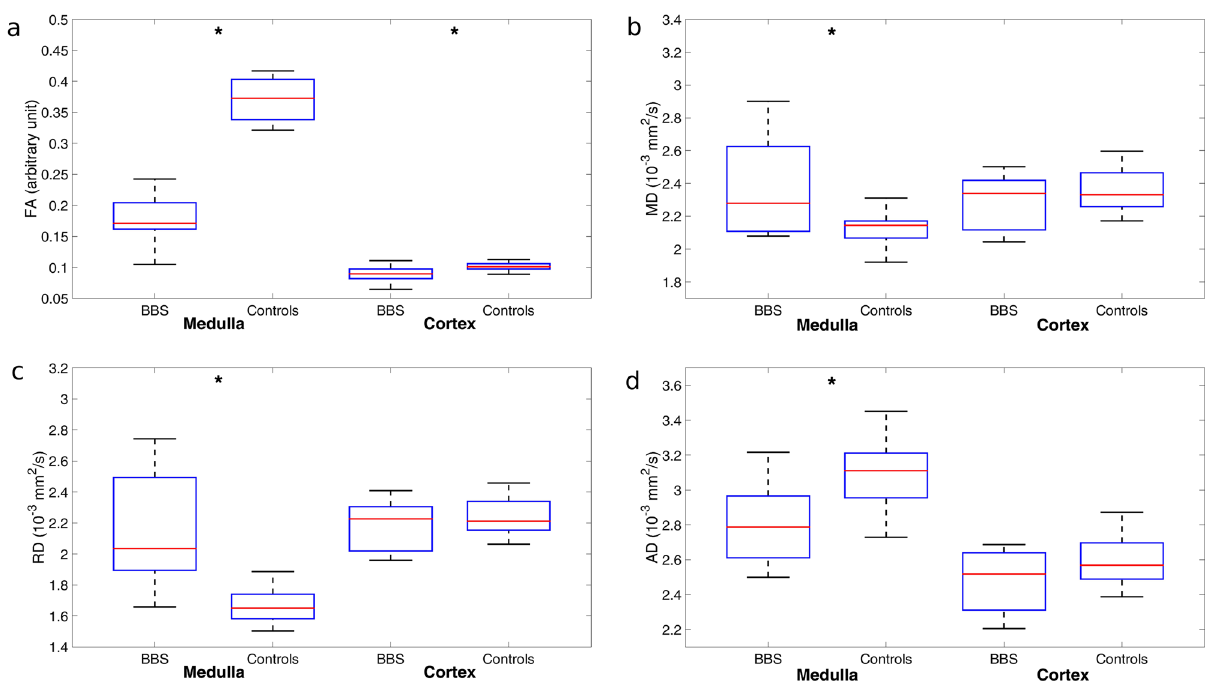
Figure 4. Distribution of both medullary and cortical mean values arising from fractional anisotropy ( a ), mean diffusivity ( b ), radial diffusivity ( c ) and axial diffusivity ( d ) for BBS and control subjects. Red lines correspond to median values and the blue boxes include from the 25th to 75th percentile of the distribution. The asterisks indicate statistically significant differences between BBS subjects and